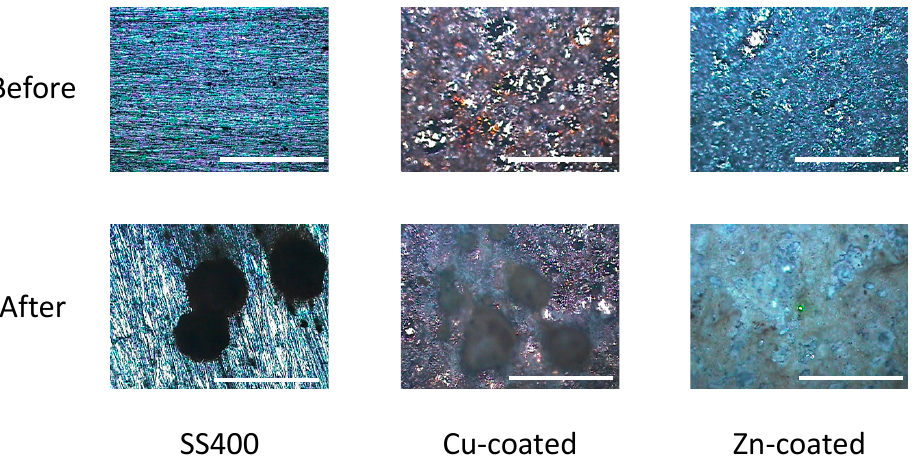
Figure 10. Digital photometric images of the surface of LBR-immerged coupons.